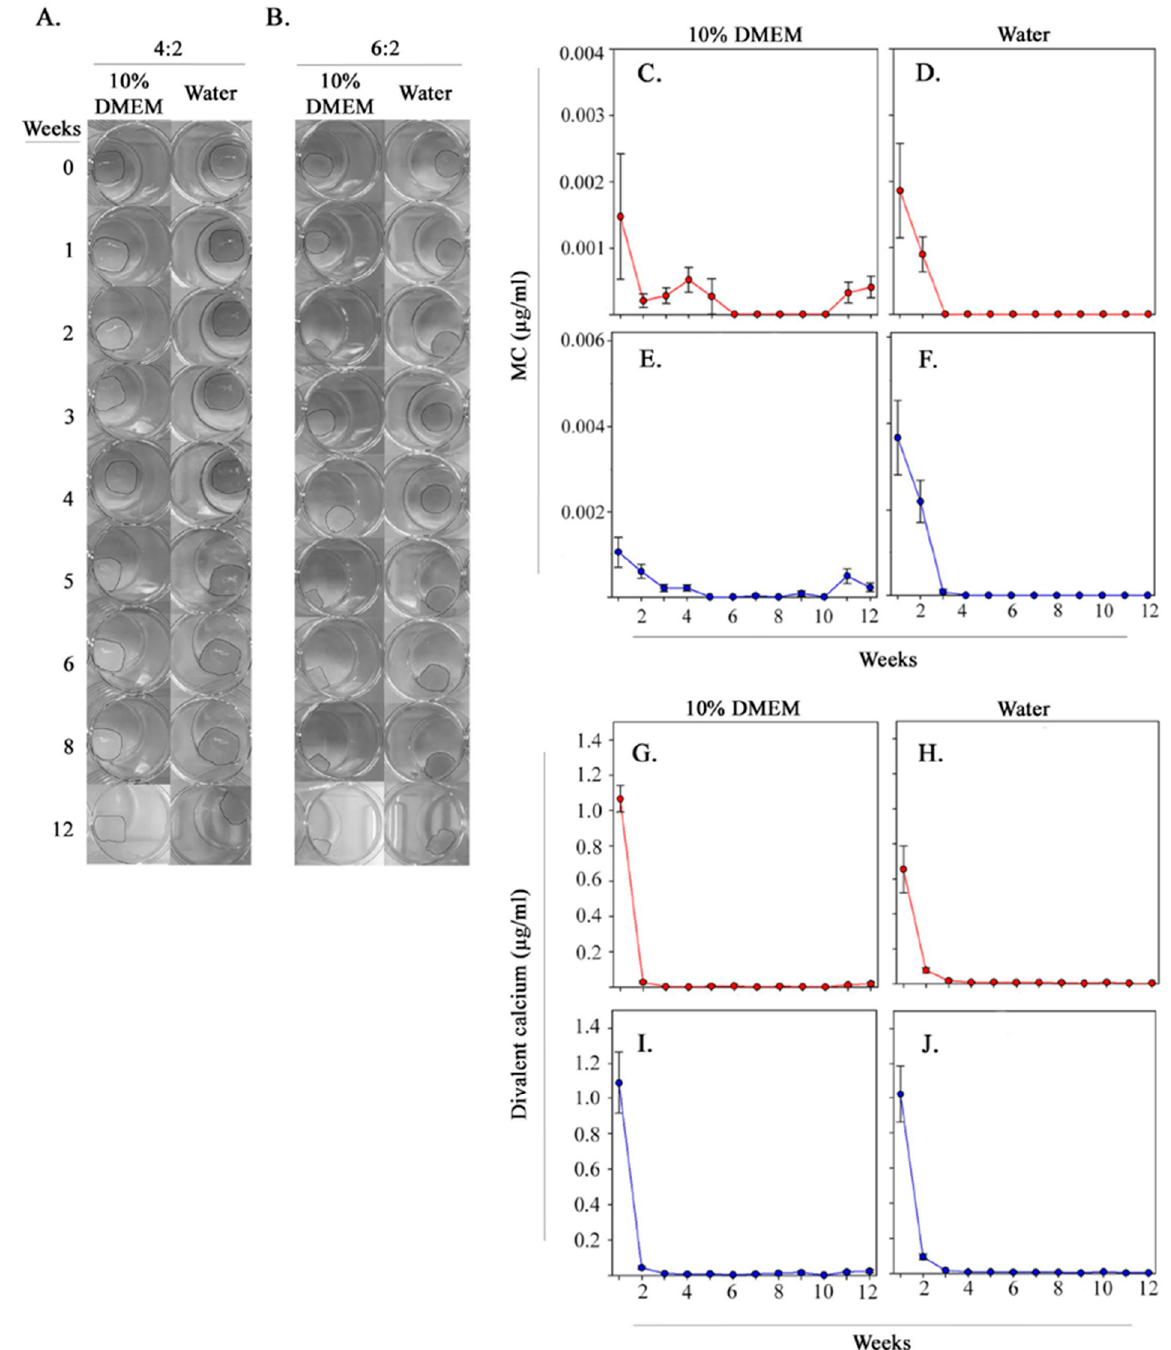
Figure 4. Stability of scaffold components in long-term culture conditions. Photographic images of ( A ) 4:2 and ( B ) 6:2 scaffolds were taken weekly for 12 weeks in 10% DMEM and deionized water, showing little bulk degradation of scaffold structure. MC ( C – F ) and calcium ( G – J ) concentrations in solution were measured weekly over 12 weeks for both 4:2 and 6:2 scaffolds to assess crosslink breakage over the culture period.